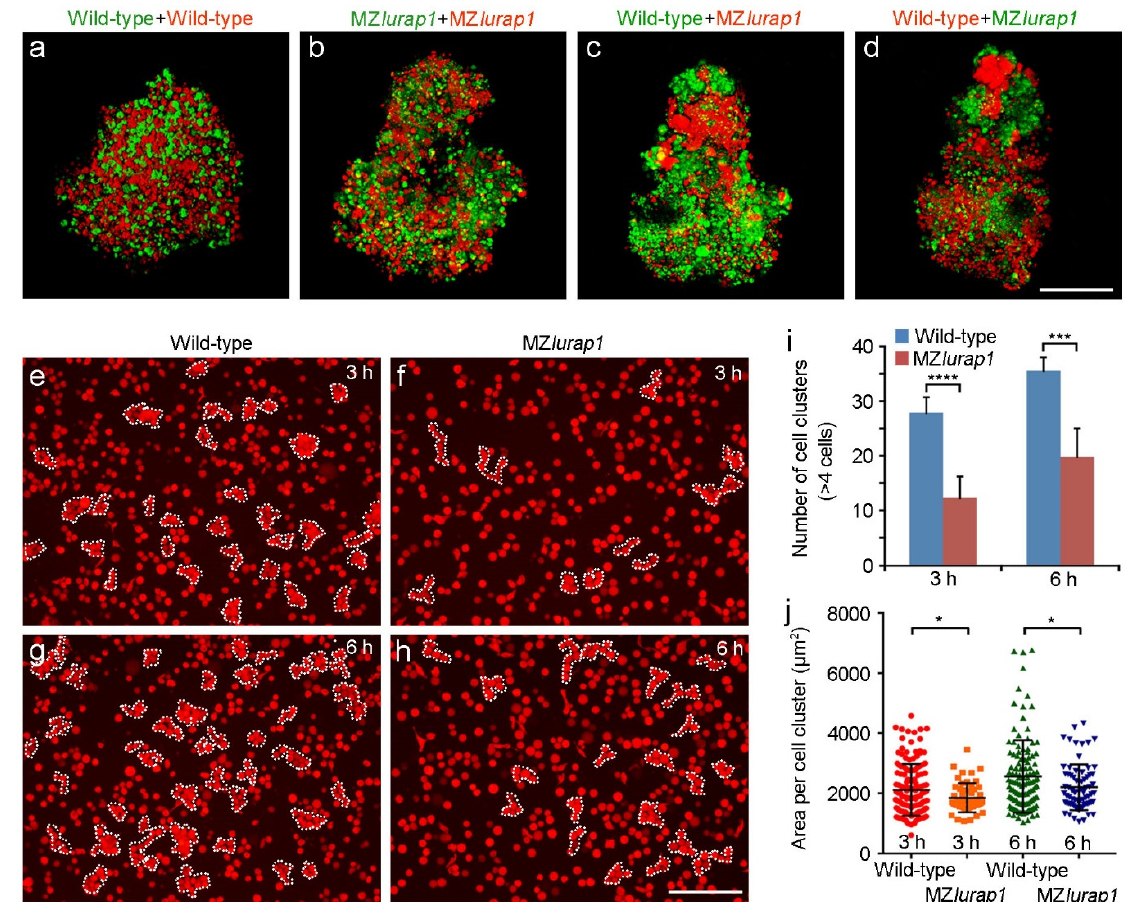
Figure 5. Reduced blastoderm cell cohesion in MZ lurap1 mutant embryos. ( a – d ) Representative images from hang drop assay show differential affinity between wild-type and MZ lurap1 mutant cells, as reflected by the preferential aggregation of cells with the same genotypes. Scale bar: 200 µm. ( e – h ) Representative images show cluster formation in wild-type and MZ lurap1 mutant cells on fibronectin-coated substrates. At 3 h and 6 h, clusters consisted of at least 4 cells in close contact are encircled by dashed lines. Scale bar: 200 µm. ( i , j ) Statistical analyses compare the number and the size of cell clusters formed by wild-type and MZ lurap1 mutant cells at 3 h and 6 h. Data were collected from 6 randomly selected view fields for each condition. Bars represent the mean value ± s.d. (*, p < 0.05; ***, p < 0.001; ****, p <